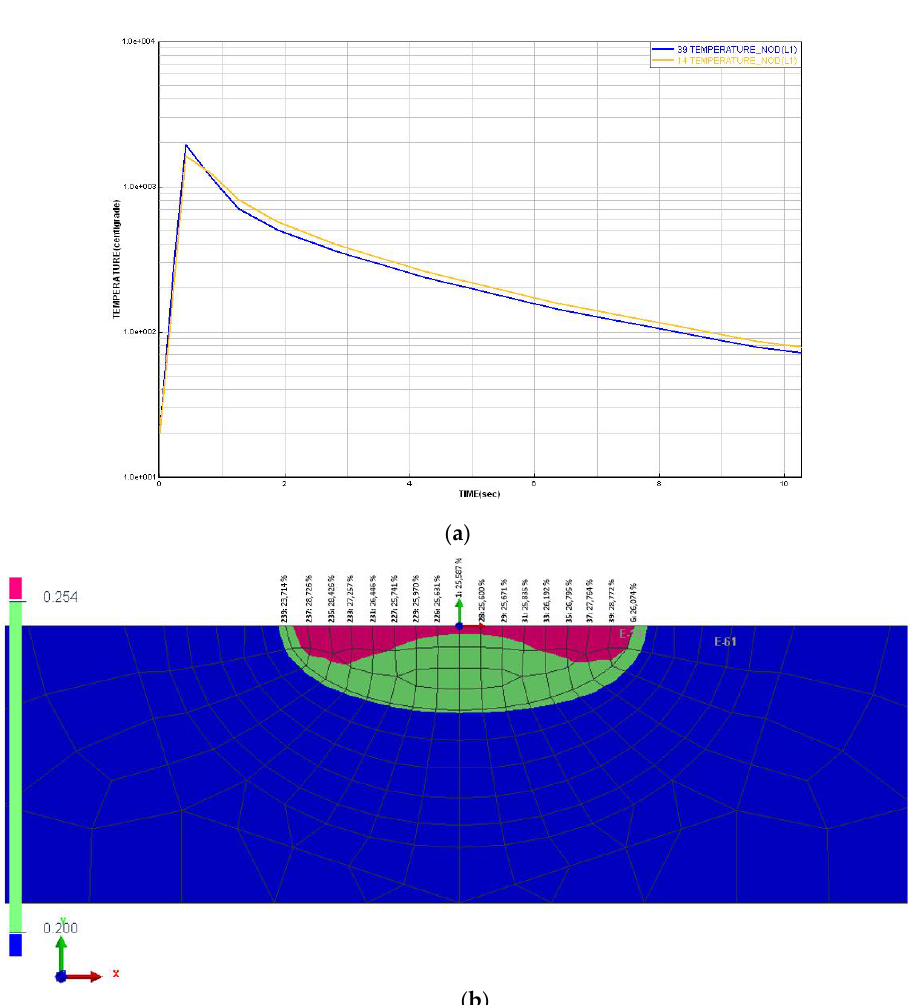
Figure 7. Results obtained from finite element method simulations. ( a ) Temperature evolution of nodes located at the surface (node 39) and the inner part of the FZ (node 14); and ( b ) martensite fraction at different zones of the FZ.